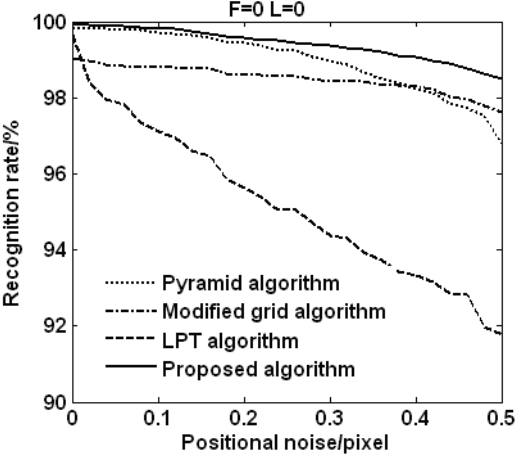
Figure 5. Recognition rates vs. positional noise (F: false star, L: lost